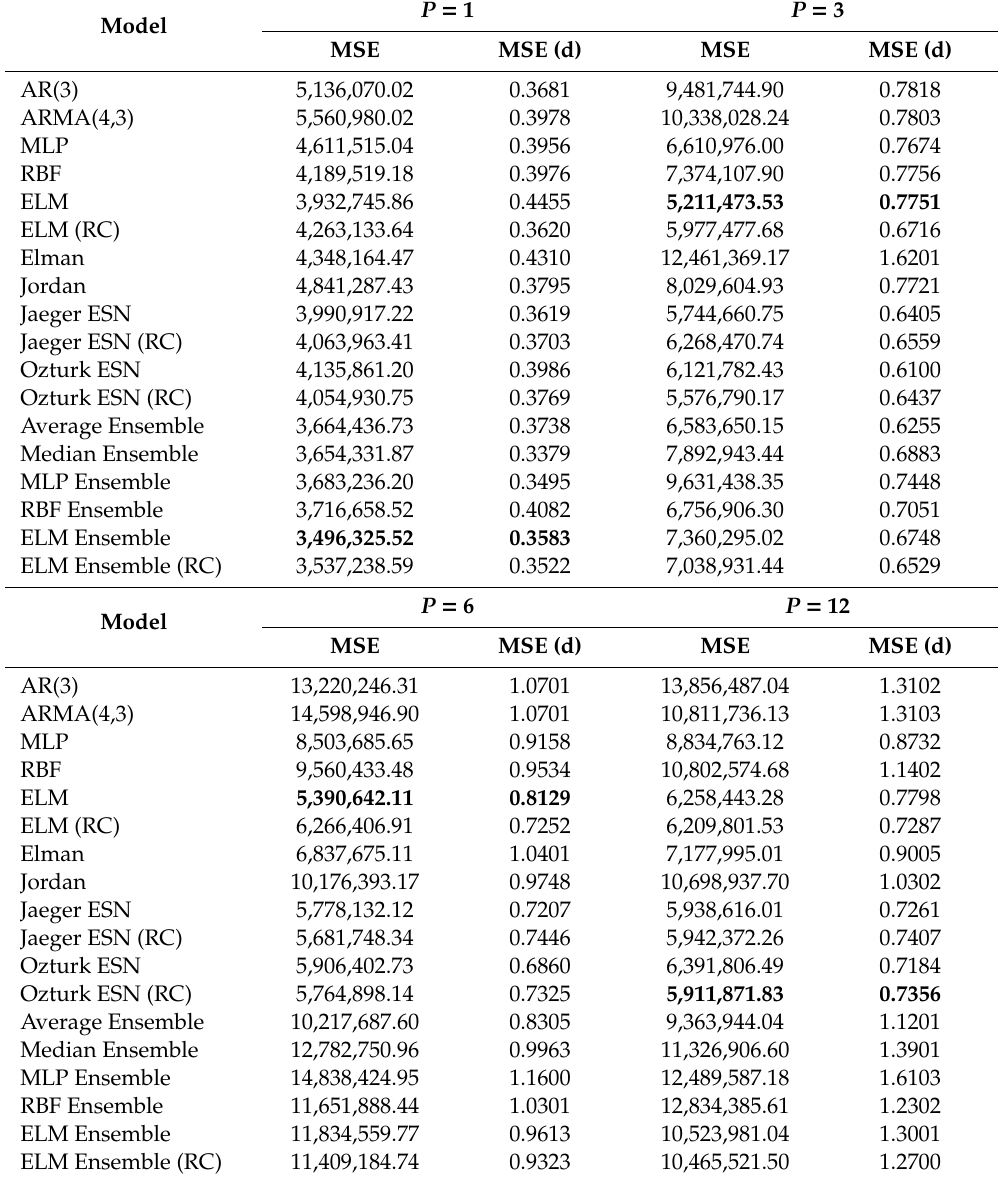
Table 3. Computational results for Belo